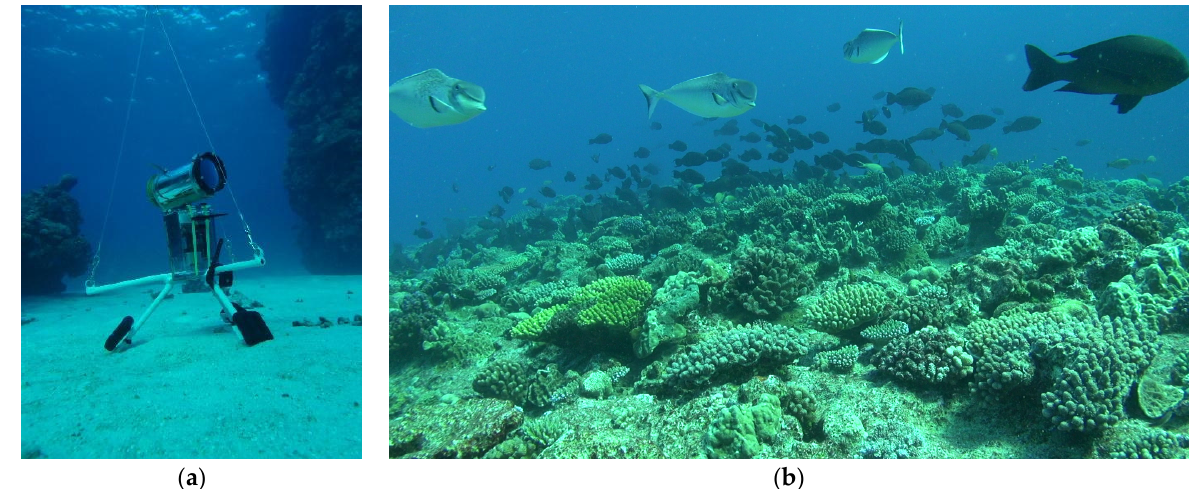
Figure 1. The STAVIRO system deployed to observe fishes and habitats (( a ), credits: B. Preuss) and example of frame recorded at Astrolabe’s reef, New Caledonia ( b ).